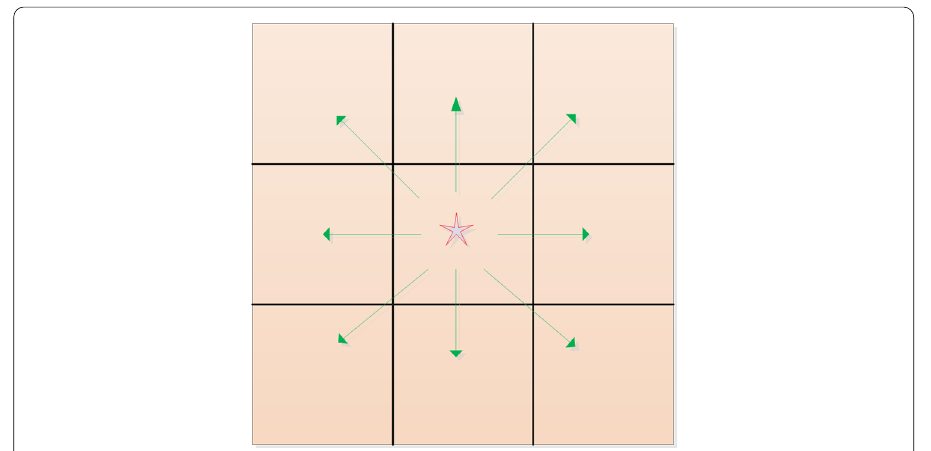
Fig. 1 Available search directions for ants